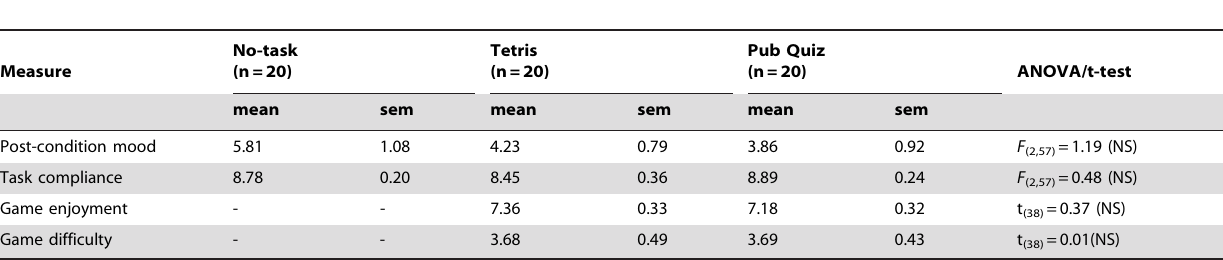
Table 4. Experiment 1 means and statistics for mood assessment, task compliance, game enjoyment and difficulty for the 10-min experimental manipulation which did not differ between conditions.